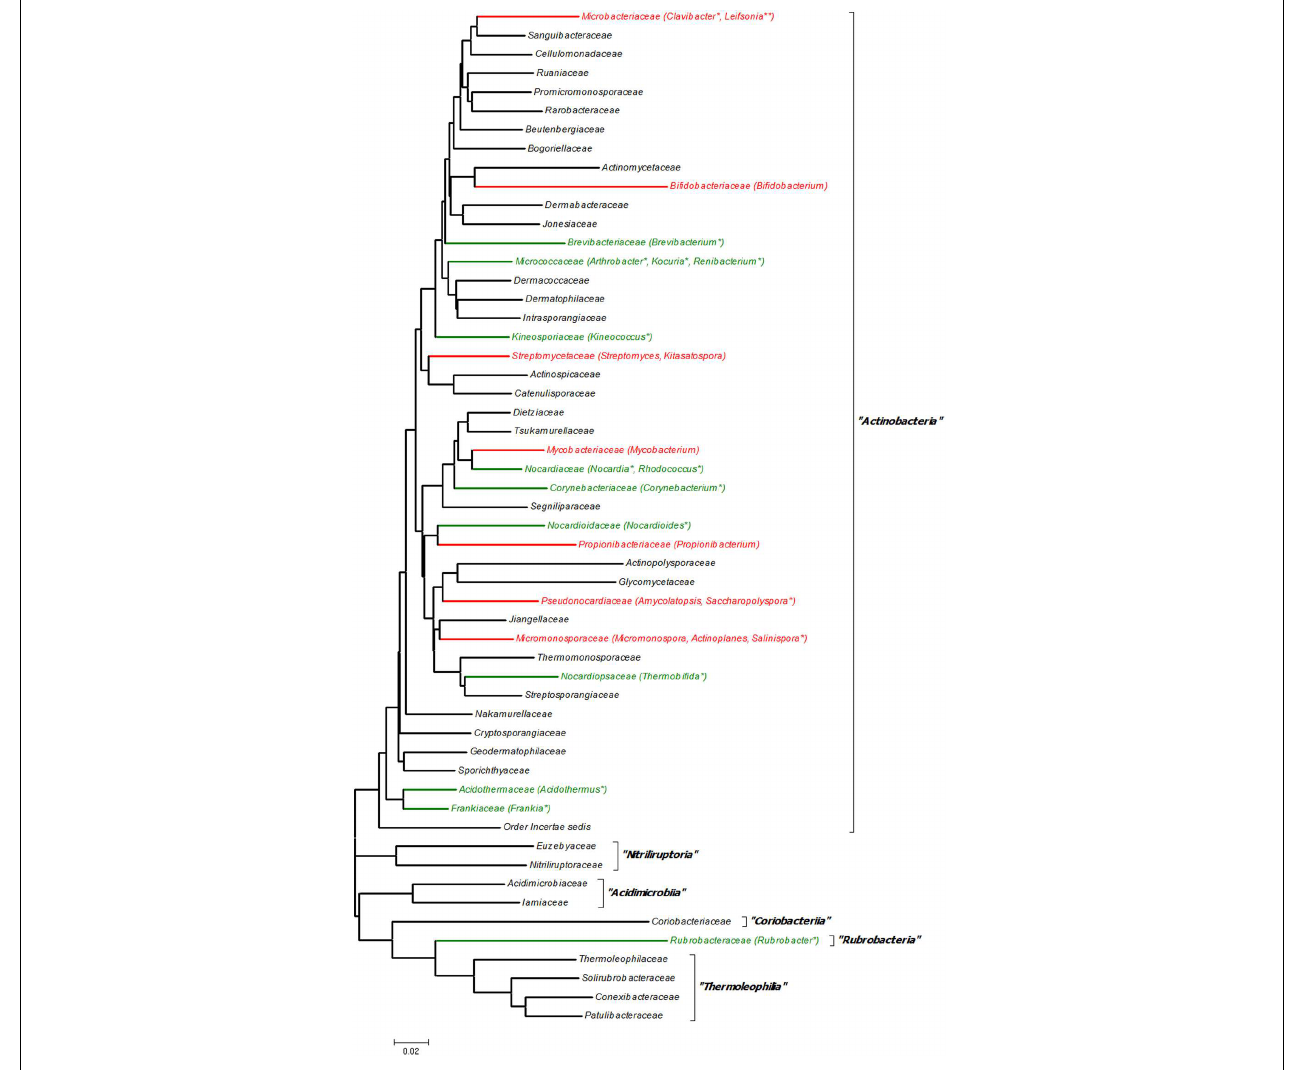
FIGURE 2 | 16S rRNA gene sequence based family tree of the phylum Actinobacteria depicting the genera with known quorum sensing systems. The evolutionary history was inferred using the Neighbor–Joining method (Saitou and Nei, 1987) using the bootstrap test of phylogeny (1000 replicates) (Felsenstein, 1985). The evolutionary distances were computed using the Kimura 2-parameter method (Kimura, 1980) Evolutionary analyses were conducted in MEGA6 (Tamura et al., 2013). A total of 54 sequences were used for constructing the tree and belonged to the type species of the type genera of each family as described in Ludwig et al. (2012) and are submitted as Supplementary Data in fasta format. Black color branch denotes family with no evidence of quorum sensing; red color denotes family with experimental evidence of quorum sensing; green color denotes family for which only gene homologs are known; ‘ ∗ ’ indicates genus for which only gene homologs are known; and ‘ ∗∗ ’ denotes genus for which putative AHL-like signal molecules are involved in quorum